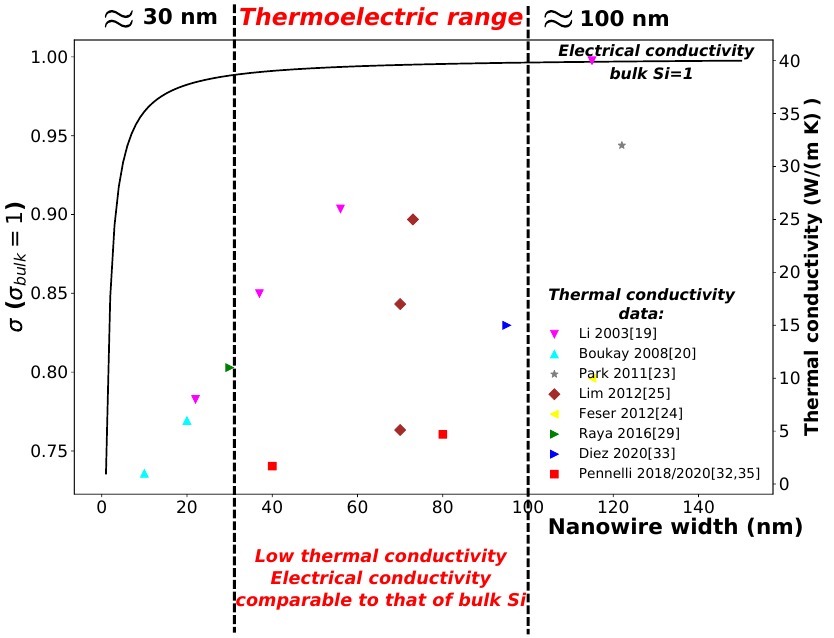
Figure 4. The electrical conductivity for n = 5.5 × 10 25 m − 3 , normalized with respect to the bulk value, is reported as a function of the nanowire width (continuous curve). Furthermore, the experi- mental measurements of the thermal conductivity (scatters) are reported. For diameters between 30 nm and 100 nm (roughly), the electrical conductivity is comparable with that in the bulk, the thermal conductivity results were instead strongly reduced for sufficiently rough